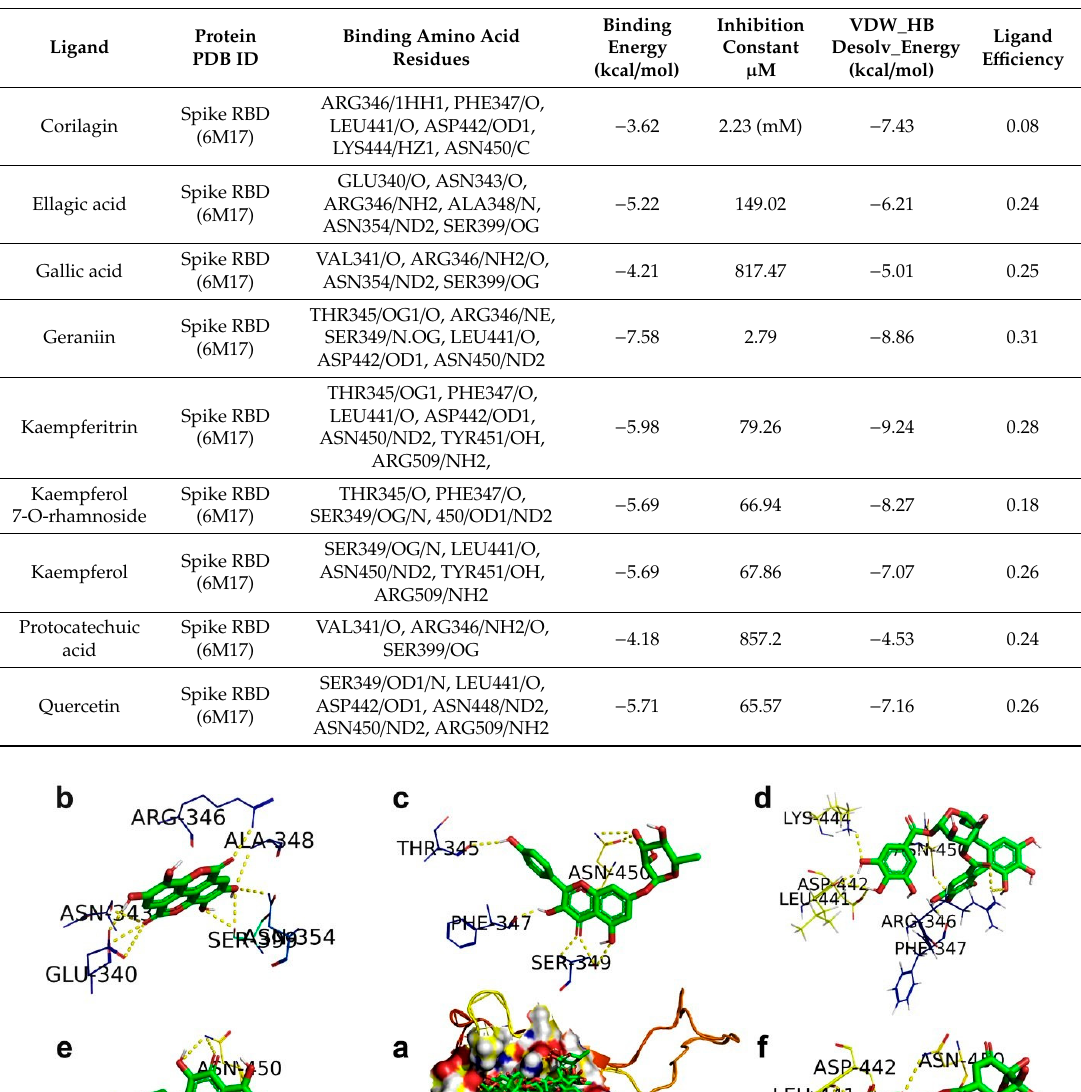
Table 2. The binding details of polyphenols present in Geranii Herba ( Geraniaceae ) with the SARS-CoV-2 spike RBD.